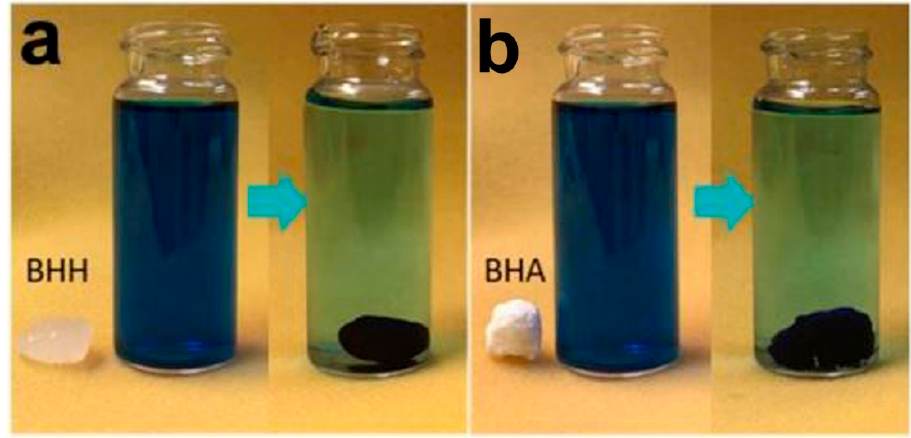
Figure 6. Digital image of methylene blue absorption by BHH ( a ) and BHA ( b ) [60].